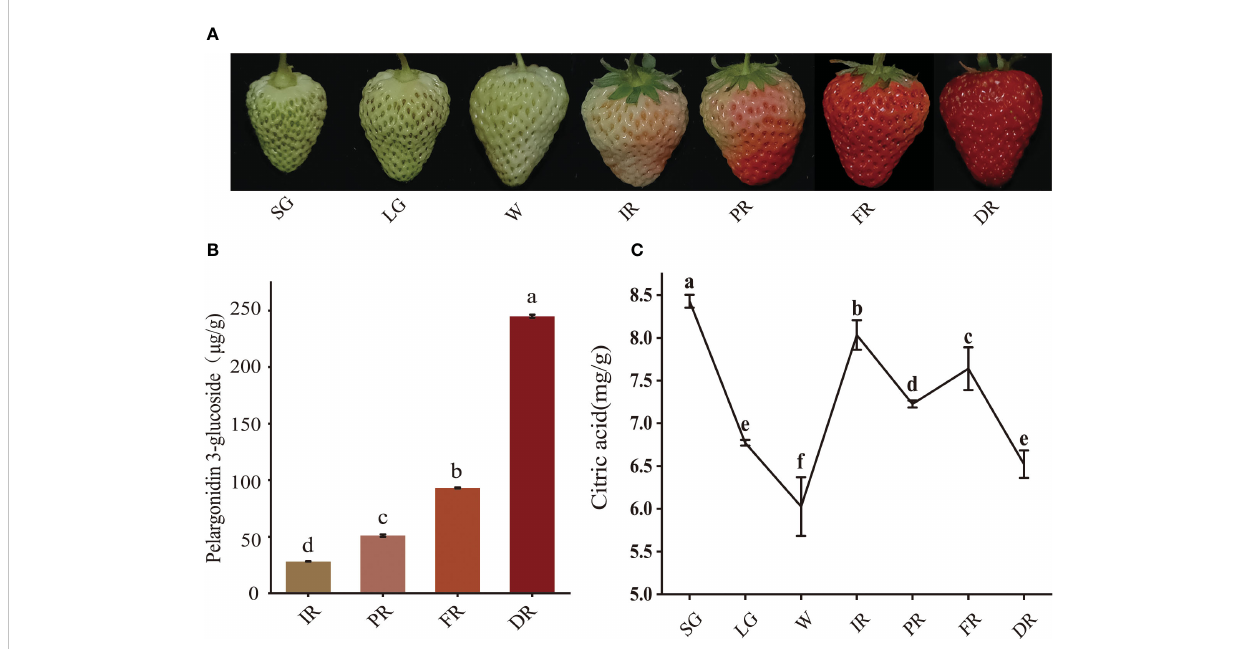
FIGURE 1 The content of pelargonidin 3-glucoside and citric acid at different developmental stages of strawberry fruit. Strawberry fruits at seven developmental stages (A) , pelargonidin 3-glucoside content (B) , citric acid content (C) . SG, small green; LG, large green; W, white; IR, initial red; PR, partial red; FR, full red; DR, dark